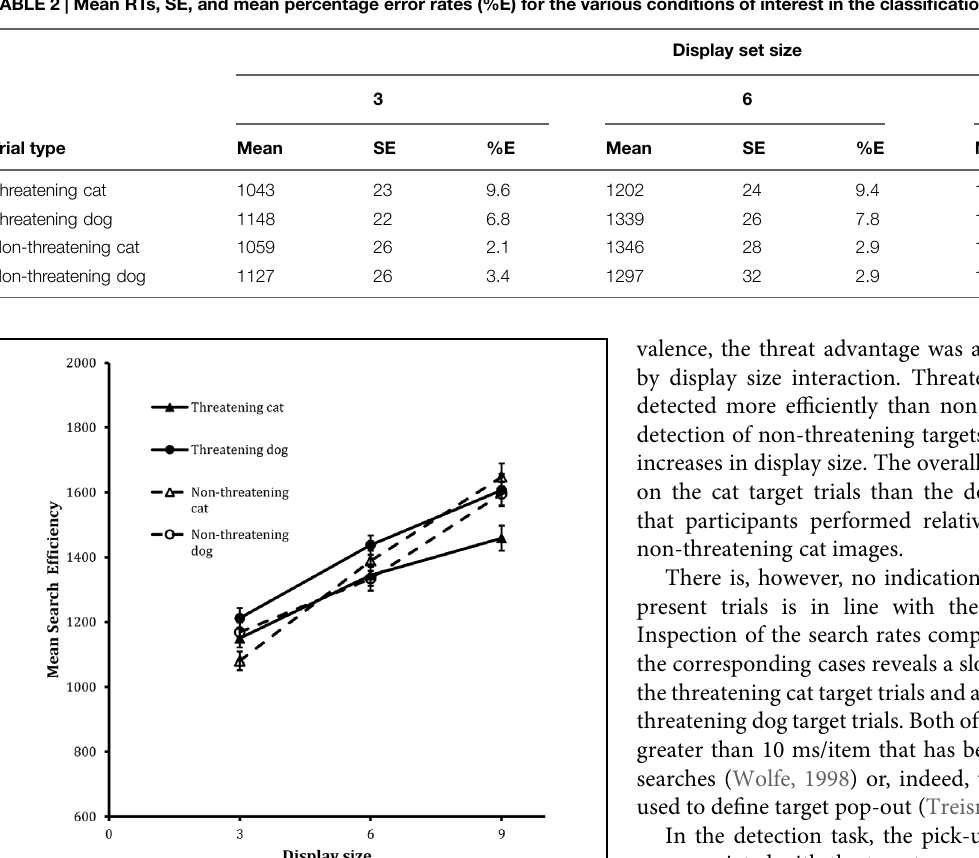
of the corresponding search functions revealed that the effect